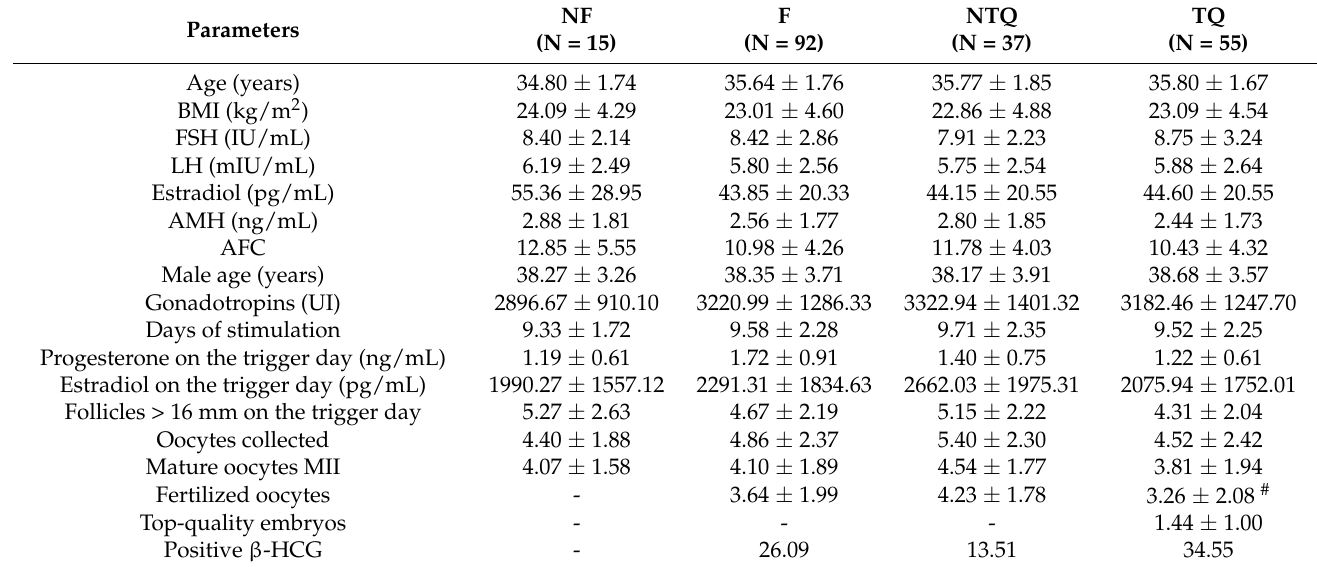
Table 1. Hormonal and clinical parameters measured in the women undergoing IVF treatment. Differences between unfertilized (NF) and fertilized (F) oocytes, and between poor-quality (NTQ) and top-quality embryos (TQ) are shown for the analyzed parameters: age, body mass index (BMI), follicle-stimulating hormone levels (FSH), luteinizing hormone levels (LH), serum levels of estradiol (E2), anti-Müllerian hormone levels (AMH), antral follicle count (AFC), male age, total units of gonadotropins, days of stimulation, progesterone and estradiol levels, and number of follicles > 16 mm on the trigger day, number of oocytes collected, number of mature oocytes MII, number of fertilized oocytes, number of top-quality embryos, and positive β -HCG values. All the data are expressed as means ± SD. Statistical analysis was performed by unpaired t -tests, considering the following pairs: F vs. NF and TQ vs. NTQ. # p < 0.05 vs.